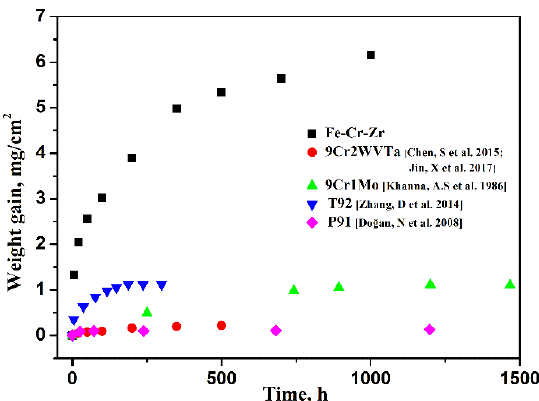
Figure 10. The weight gain curves of Fe-Cr-Zr alloy oxidized in air at 923 K compared with the ferritic/martensitic steels (Data from [29–33]).